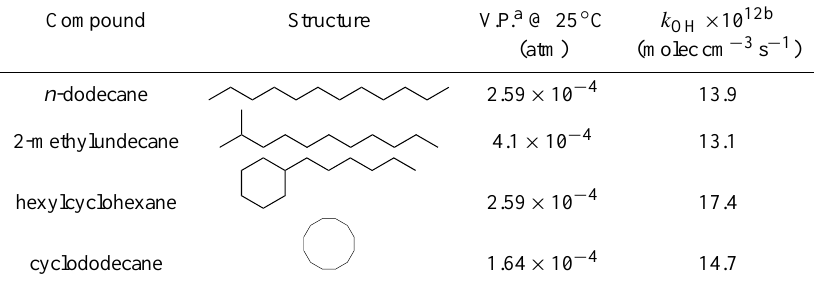
Table 1. C 12 compounds studied.